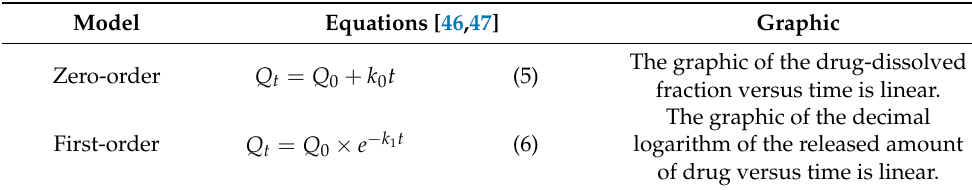
Table 11. Mathematical model of drug-release